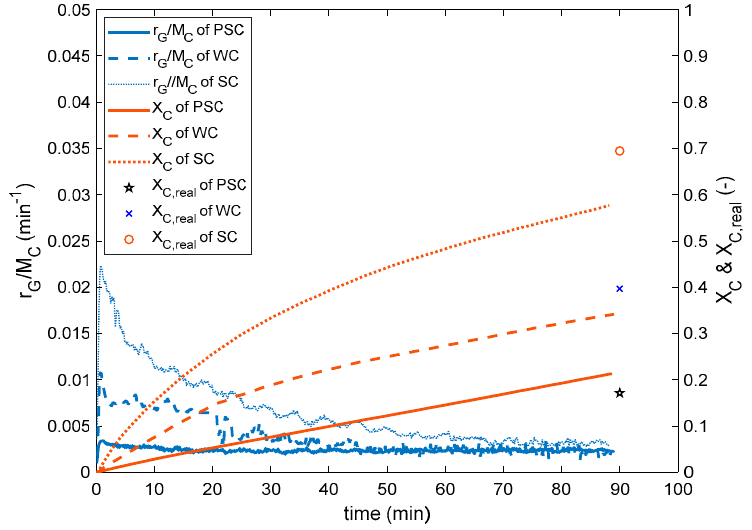
Figure 5. Comparison of calculated r G /M C and Xc during 90 min tar reforming over PSC, WC, and SC at 850 °C.